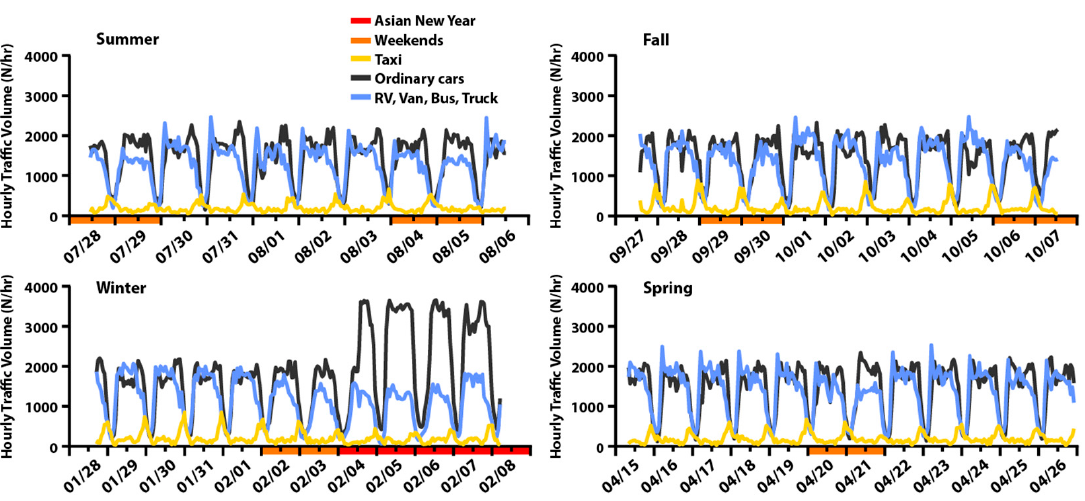
Figure 3. Traffic volume related to types of vehicles in each season [27].